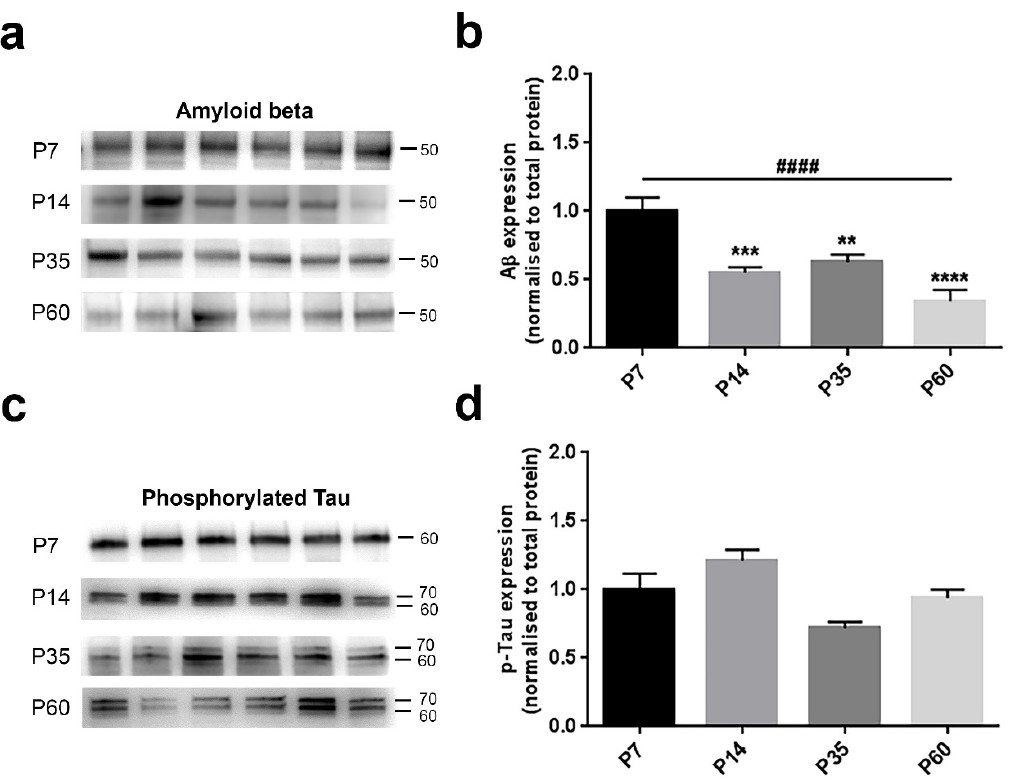
Figure 5. Amyloid beta and phosphorylated Tau levels are differently affected during postnatal brain development. ( a , c ) Representative immunoblots showing the protein expression in six hemislices from one randomly-chosen animal per age. ( b – d ) Bar graphs indicating the protein profile related to four different ages. ( a , b ) Amyloid levels were markedly influenced across ages, showing a substantial decreasing profile from P7–P60 (trend analysis post-hoc test) and also individual differences between P7 and older stages (Bonferroni’s post-hoc test). ( c , d ) Tau phosphorylation did not show any age-related trend, nor inter-individual variations. All values are normalised against the P7 group, considered as the control. Asterisks indicate a difference between P7 and the other groups (Bonferroni’s post-hoc test), while hashes represent the linear trend among groups (trend analysis post-hoc test). Data are indicated as the mean ± SEM. n = (hemislices, rats) is (24, 4). ** p < 0.01, *** p < 0.001 **** ,#### p < 0.0001.